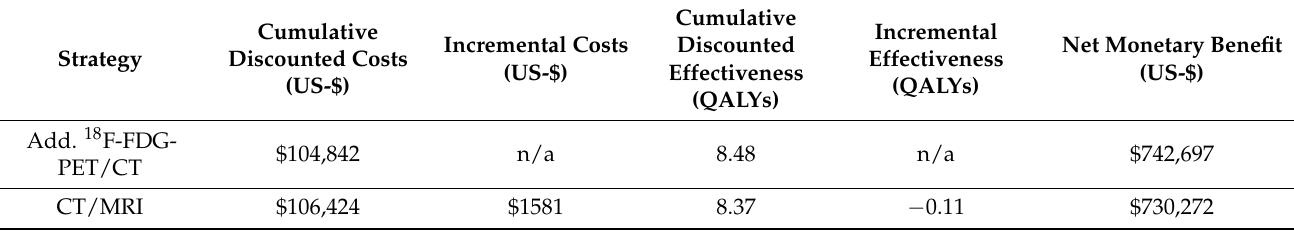
Table 2. Results of the base-case cost-effectiveness analysis comparing CT/MRI with additional 18 F-FDG-PET/CT examination. Cumulative discounted costs and effectiveness for a time frame of 15 years.